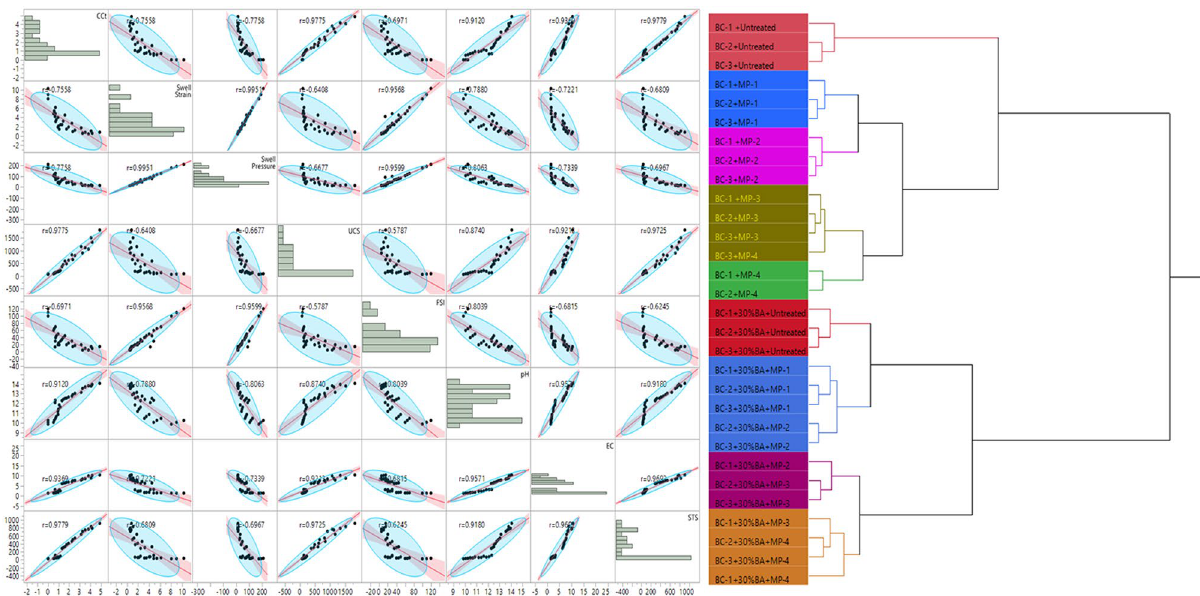
Figure 6. Multivariate scatter and hierarchical clustering dendrogram plot of MICP treated expansive